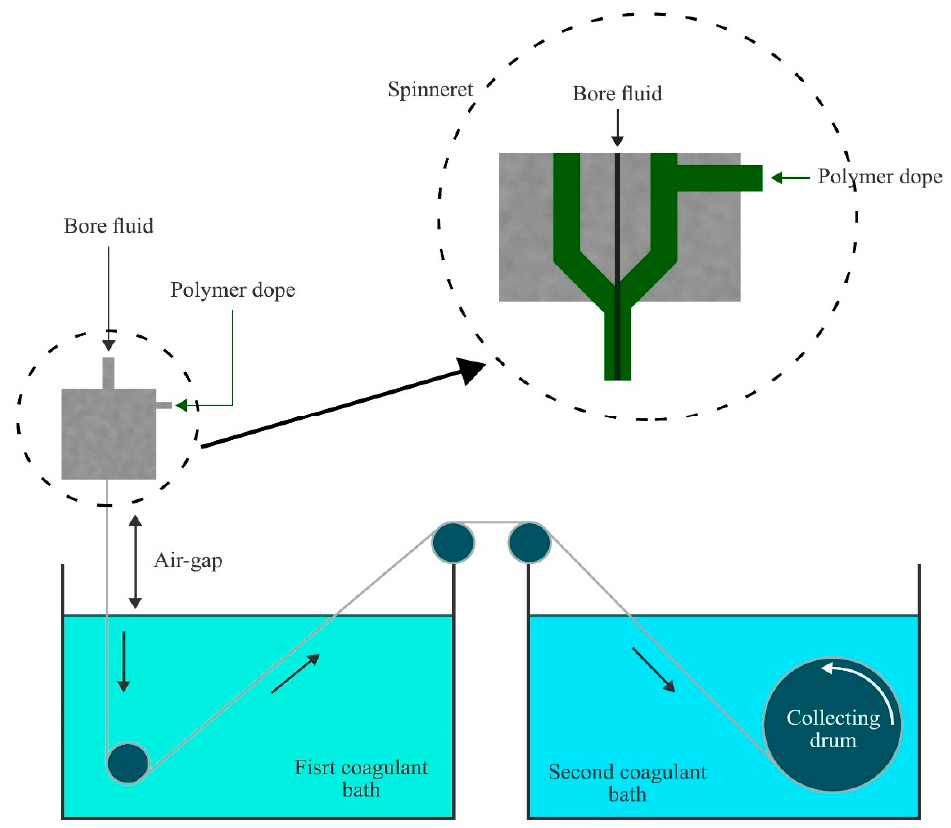
Figure 8. Spinning process of hollow-fiber membranes.